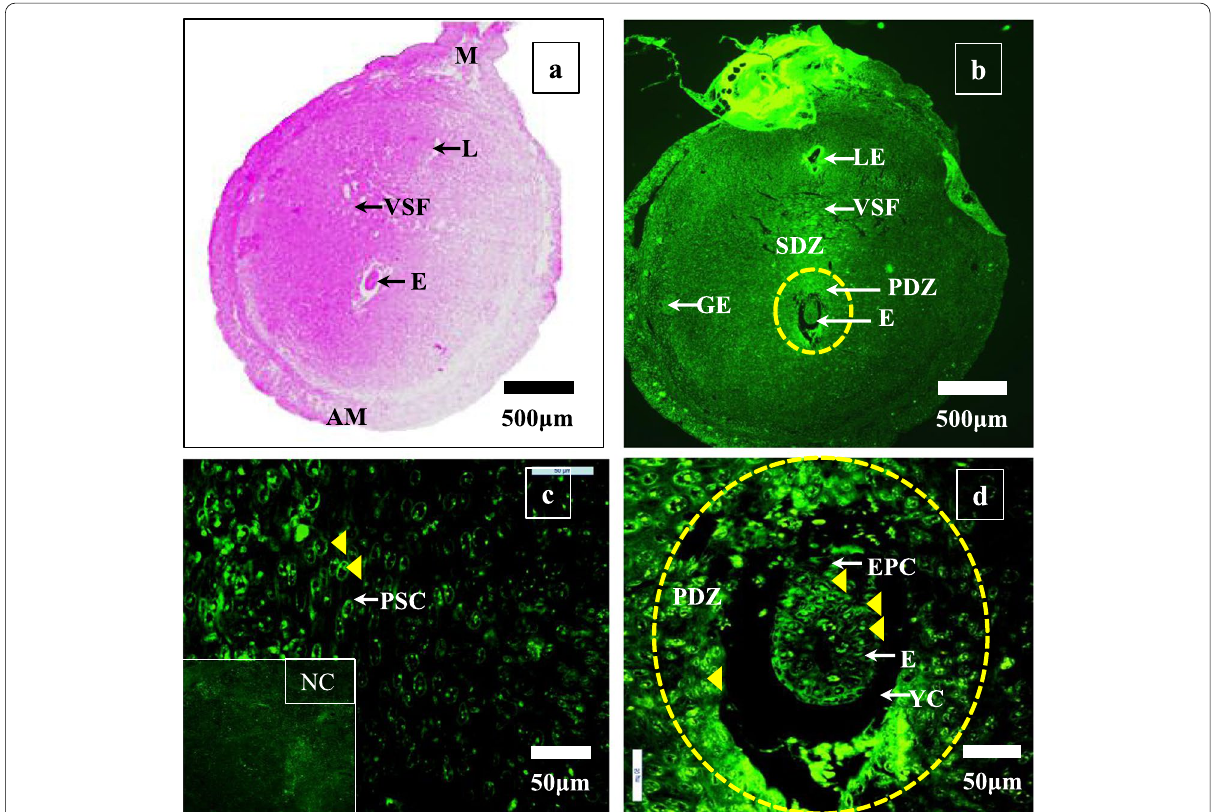
Fig. 4 Immunofluorescence of KLF5 on D6 mice uterus using FITC-conjugated antibody. The protein was localized in the luminal epithelium (LE), embryo (E), and proliferating stromal cell (PSC) of PDZ and secondary decidual zone (SDZ). The arrowhead indicates the